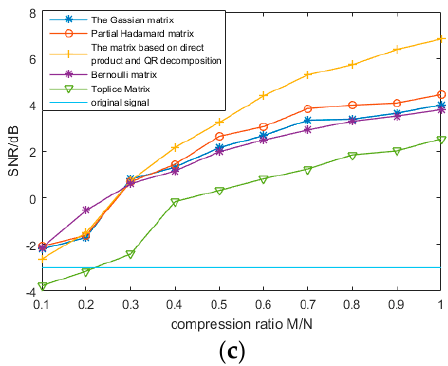
Figure 6. SNR enhancement comparison by different types of measurement matrices for different SNR ( a ) SNR = 4 dB; ( b ) SNR = 0 dB; ( c ) SNR = − 3 dB.